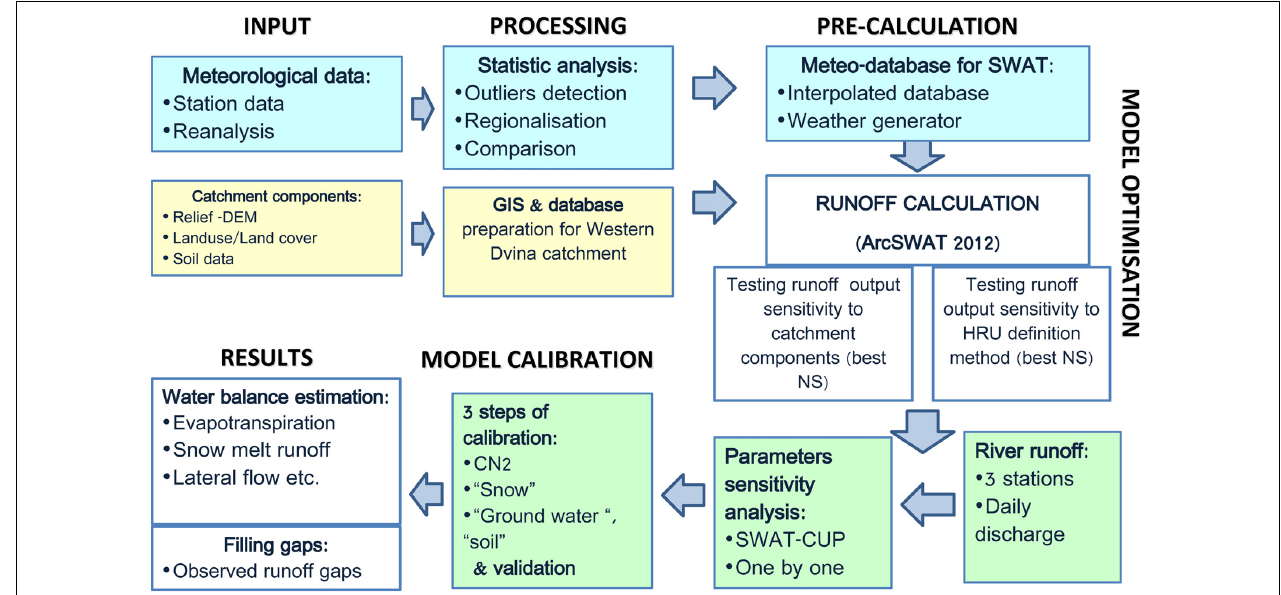
FIGURE 2 | The conceptual framework of the study: water balance model flow of Western Dvina catchment.